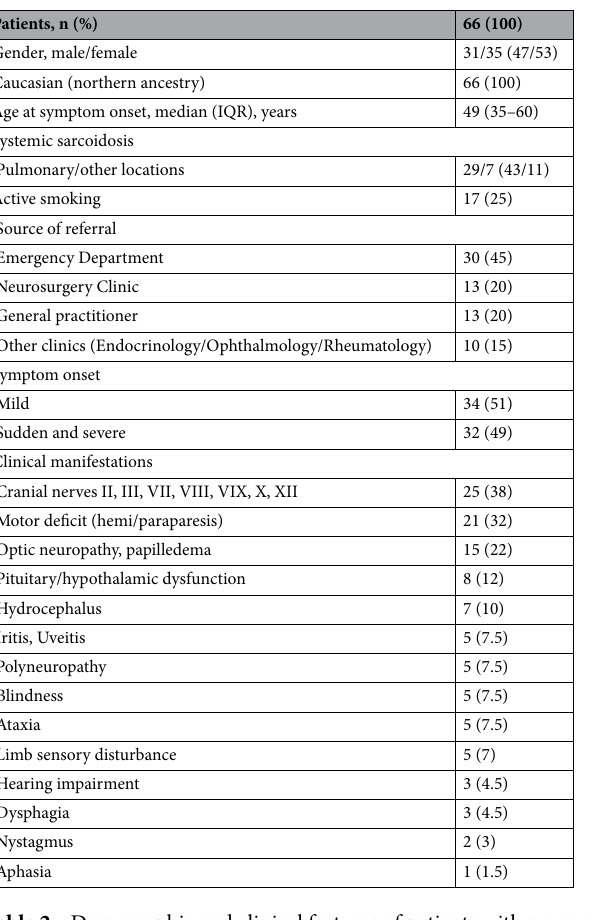
Table 2. Demographic and clinical features of patients with neurosarcoidosis (n =